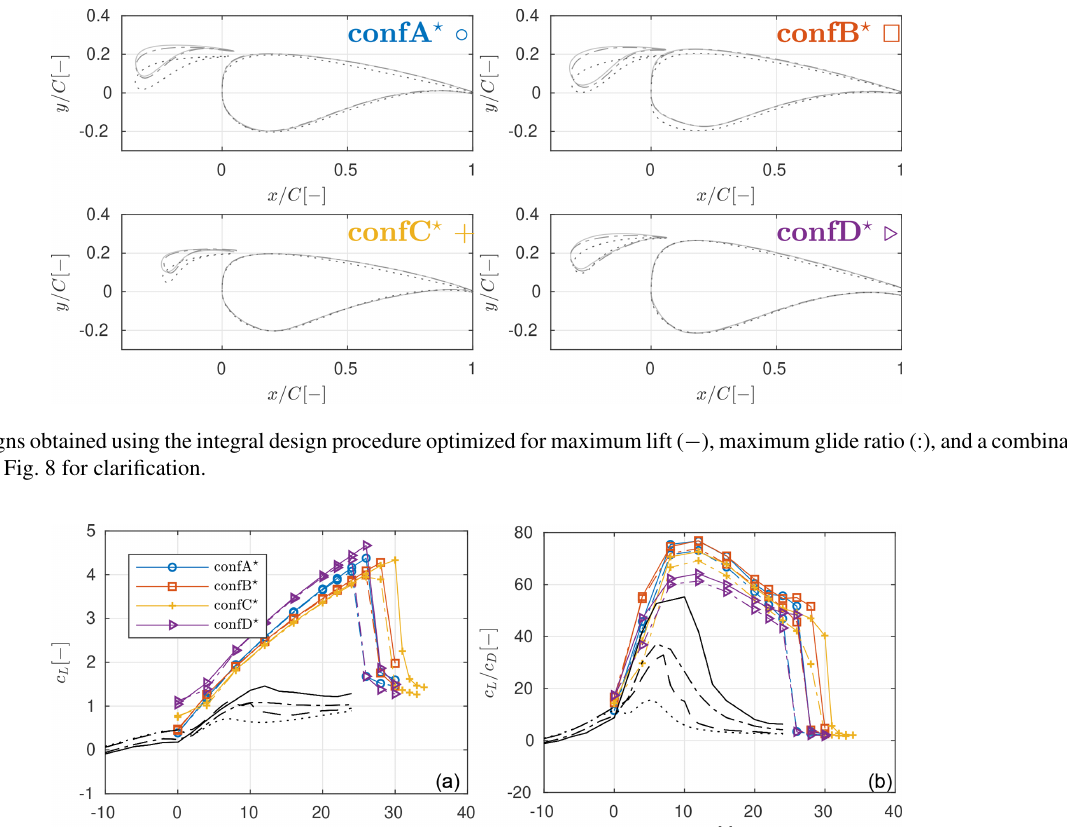
gles of attack are the two design angles α = 12 ◦ and α = 20 ◦ , as well as an angle α = 28 ◦ that is close to either stall or post- stall, depending on the